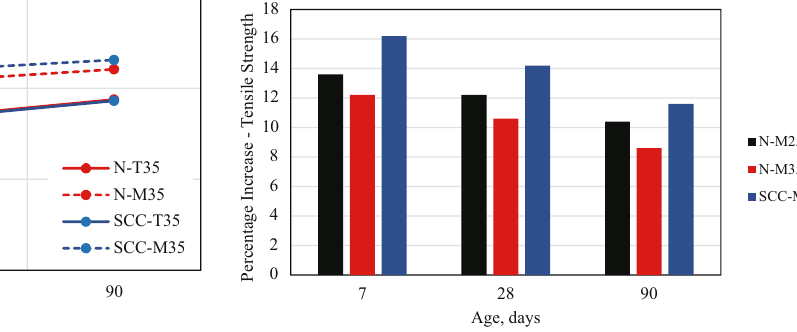
Figure 8: Tensile strength results for normal and SCC mixes using tap and magnetized water.